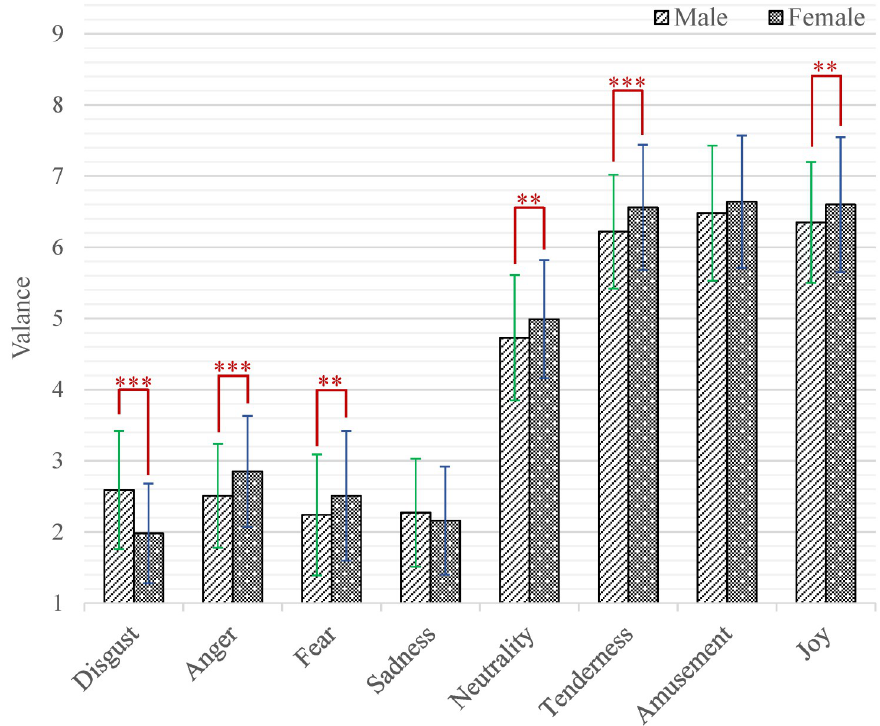
Fig 2. The valence scores of each category of emotion-inducing short videos between male and female. Statistical significance: * p < 0.05, ** p < 0.01, *** p < 0.001. Unless marked with the asterisk, no significant differences between these groups were